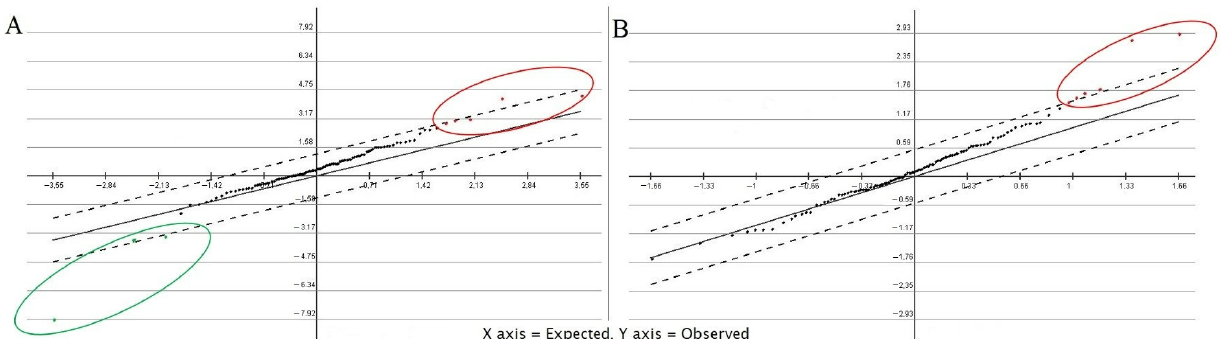
Figure 3. Statistical analysis of 111 unigenes according to FPKM values related to BRV resistance in R. nigrum cv. Aldoniai at 2 dpi ( A ) and 4 dpi ( B ). The SAM graphs were generated by MeV v. 4.8 package. Red dots indicate up-regulated genes, and green dot indicate down-regulated genes. To visualize the differentially expressed genes in response to a virus attack, a selected set of genes are presented in heatmaps. Figure 4 represents only the 14 significant expression patterns according to FPKM values among mock-inoculated and BRV-inoculated plants at 2 and 4 dpi (Figure 4). On the second day after BRV infection, five unigenes (Cluster-